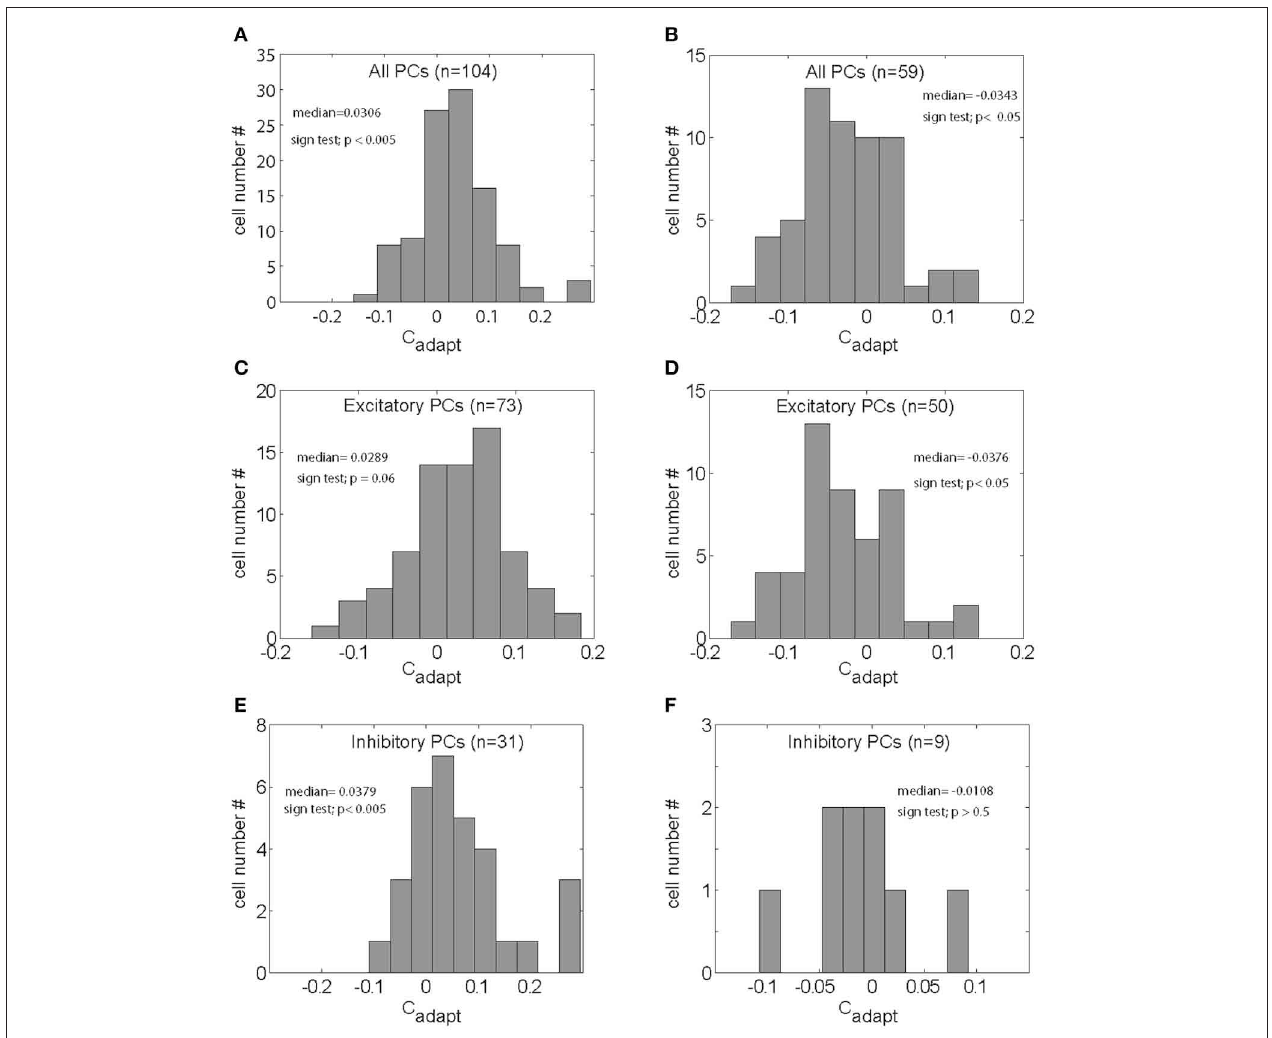
excitatory PC SS tested for gain-increase SPA (C) and gain-decrease SPA (D) , respectively. (E,F) Distribution of C adapt for the inhibitory PC SS subjected to gain-increase (E) and gain-decrease SPA respectively (F)